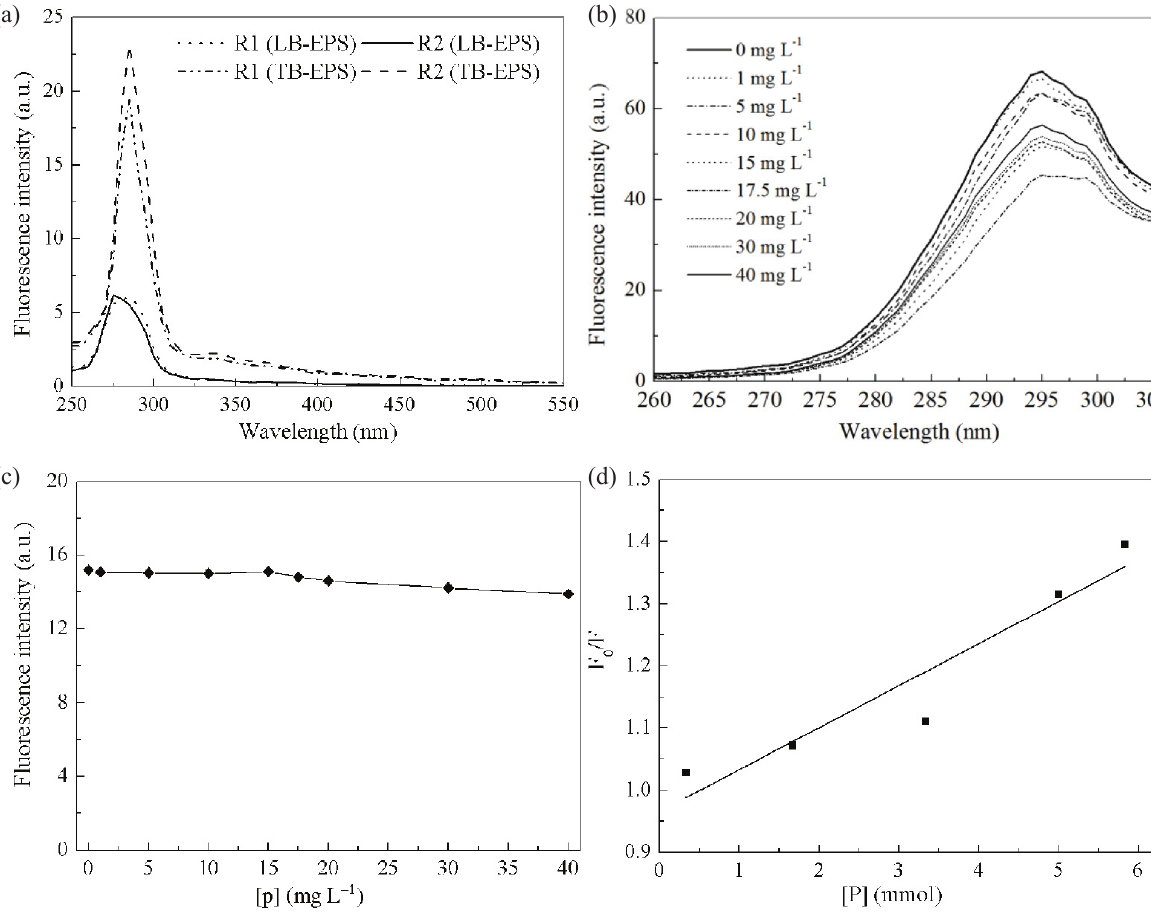
Fig. 6 – Synchronous fluorescence spectra of LB-EPS, TB-EPS in R1 and R2 (a) and EPS (b); Fluorescence intensity of the PN-like substances of EPS (c); Stern-Volmer plot of EPS with increased dosages of P